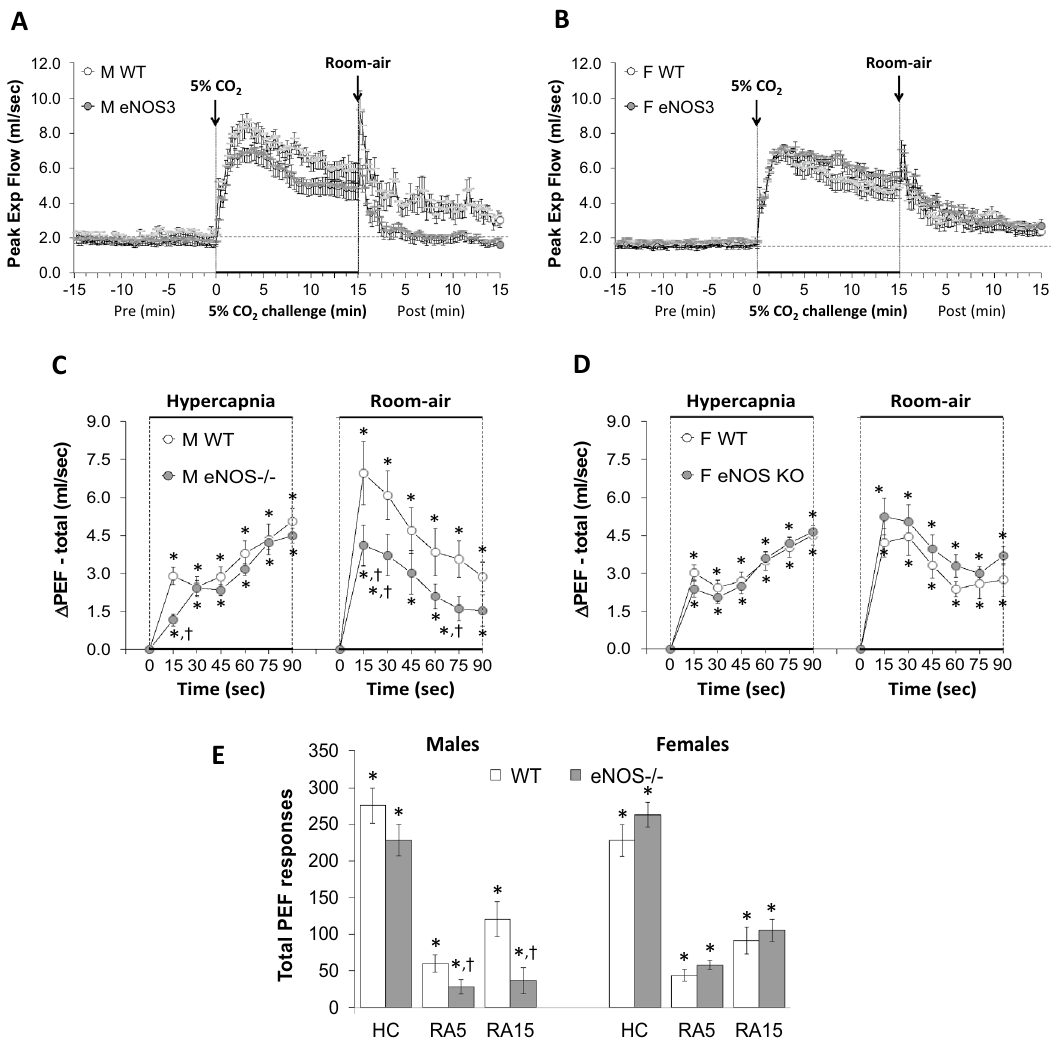
Figure 9. Panels ( A ) and ( B ) Peak Expiratory Flow (PEF) values before, during hypercapnic (HC) gas challenge (5% CO 2 , 21% O 2 , 74% N 2 ) and upon return to room-air in male (M) and female (F) wild-type (WT) and eNOS knock-out (eNOS-/-) mice. Panels ( C ) and ( D ) Arithmetic changes in PEF in male and female WT and eNOS- /- mice during the first 90 s of exposure to HC challenge and the first 90 s upon return to room-air. Panel ( E ) Total changes in PEF in male and female WT and eNOS-/- mice during HC challenge and during the first 5 min (RA5) and entire 15 min (RA15) return to room-air. The data are presented as mean ± SEM. * P < 0.05, significant change from pre-values. † P < 0.05, eNOS-/- versus WT within each increases in PIF during HCC were similar in both groups (Panels C and D). The total (arithmetic) responses (Panel E, column HC) were similar in female WT and eNOS-/- mice, but significantly less in the male eNOS- /- mice compared to the WT males. Upon return to room-air, PIF returned to baseline at an initial faster rate in male eNOS-/- mice than male WT mice (Panels A and C) and returned to baseline at a similar initial rate in eNOS-/- and WT female mice (Panels B and D). After the initial 90 s, PIF values reached baseline values more quickly in eNOS-/- males compared to WT males than eNOS-/- females compared to WT females, therefore the total responses over the 5 min and 15 min periods were significantly smaller in the eNOS-/- males than the WT males (Panel E, columns RA5 and RA15). There was no difference in the room-air total responses in female WT and eNOS-/- mice (Panel E, columns RA5 and RA15). As seen in Fig. 9, HCC elicited robust increases in PEF in male and female WT and eNOS-/- mice (Panels A and B). The rate of reaching the initial increases in PEF (Panels C and D) during HCC were similar in both groups. The total (arithmetic) responses (Panel E, column HC) were similar in WT and eNOS-/- females, but significantly less in the male eNOS-/- mice than male WT mice. Upon return to room-air, PEF returned to baseline values at an initial faster rate in male eNOS-/- mice compared to the male WT mice (Panels A and C) and returned to baseline at a similar initial rate in female eNOS-/- and WT mice (Panels B and D). After the initial 90 s, PEF values reached baseline values more quickly in male eNOS-/- mice compared to WT males than female eNOS-/- mice compared to WT females, therefore the total responses over the 5 min and 15 min periods were significantly smaller in eNOS-/- males than in WT